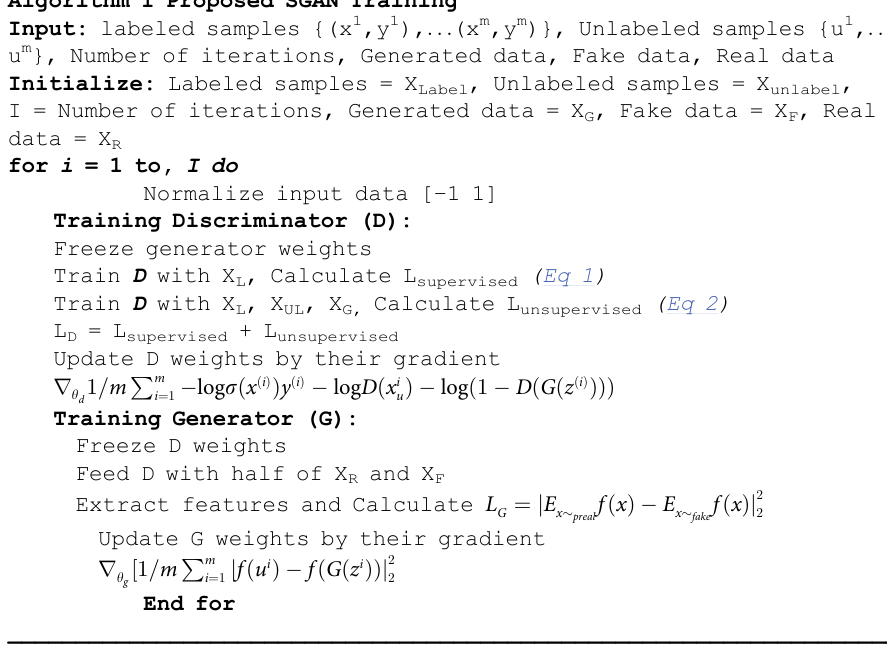
Algorithm 1 Proposed SGAN